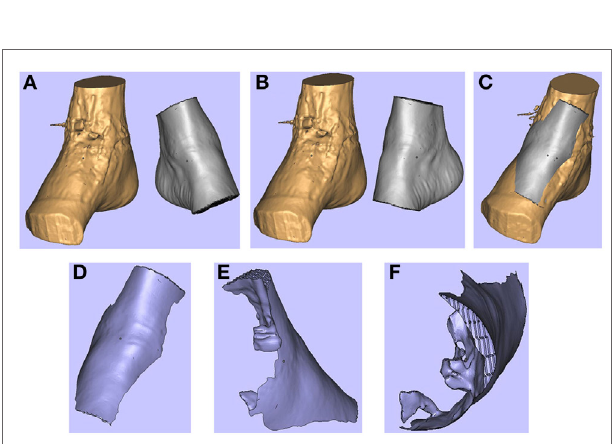
FiGURe 4 | 3D images of the right (pathological) ankle is juxtaposed to the left (normal) ankle (A). The left ankle is reflected (B) and superimposed on to the right ankle (C). These images are subtracted from each other to produce a “reverse” model of the soft tissue defect (D-F) . Reproduced with permission from Microsurgery